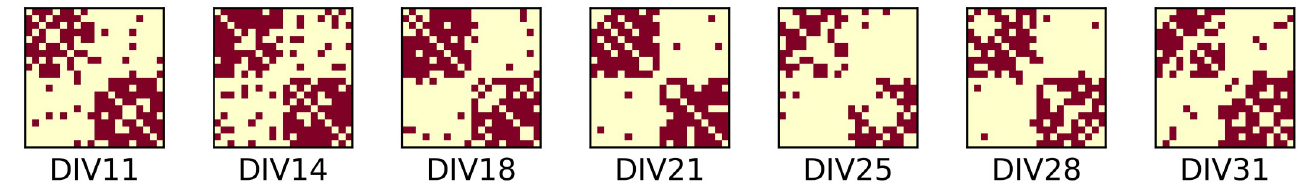
Fig 4. Adjacency matrices of synthetic networks generated for model